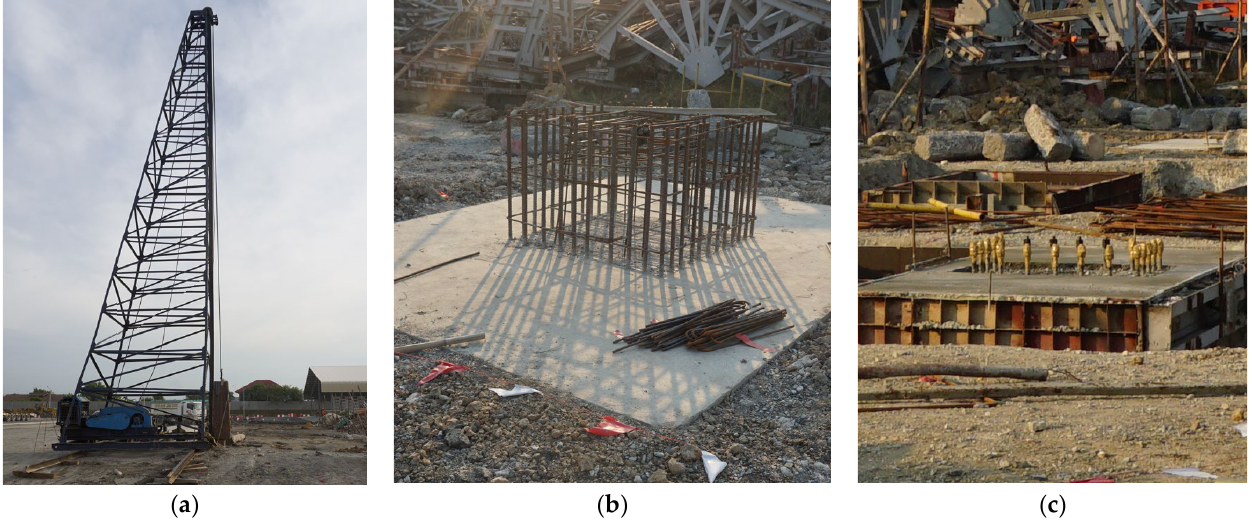
Figure 6. Construction details of foundations: ( a ) driving piles, ( b ) pile cap, and ( c ) steel bolts.